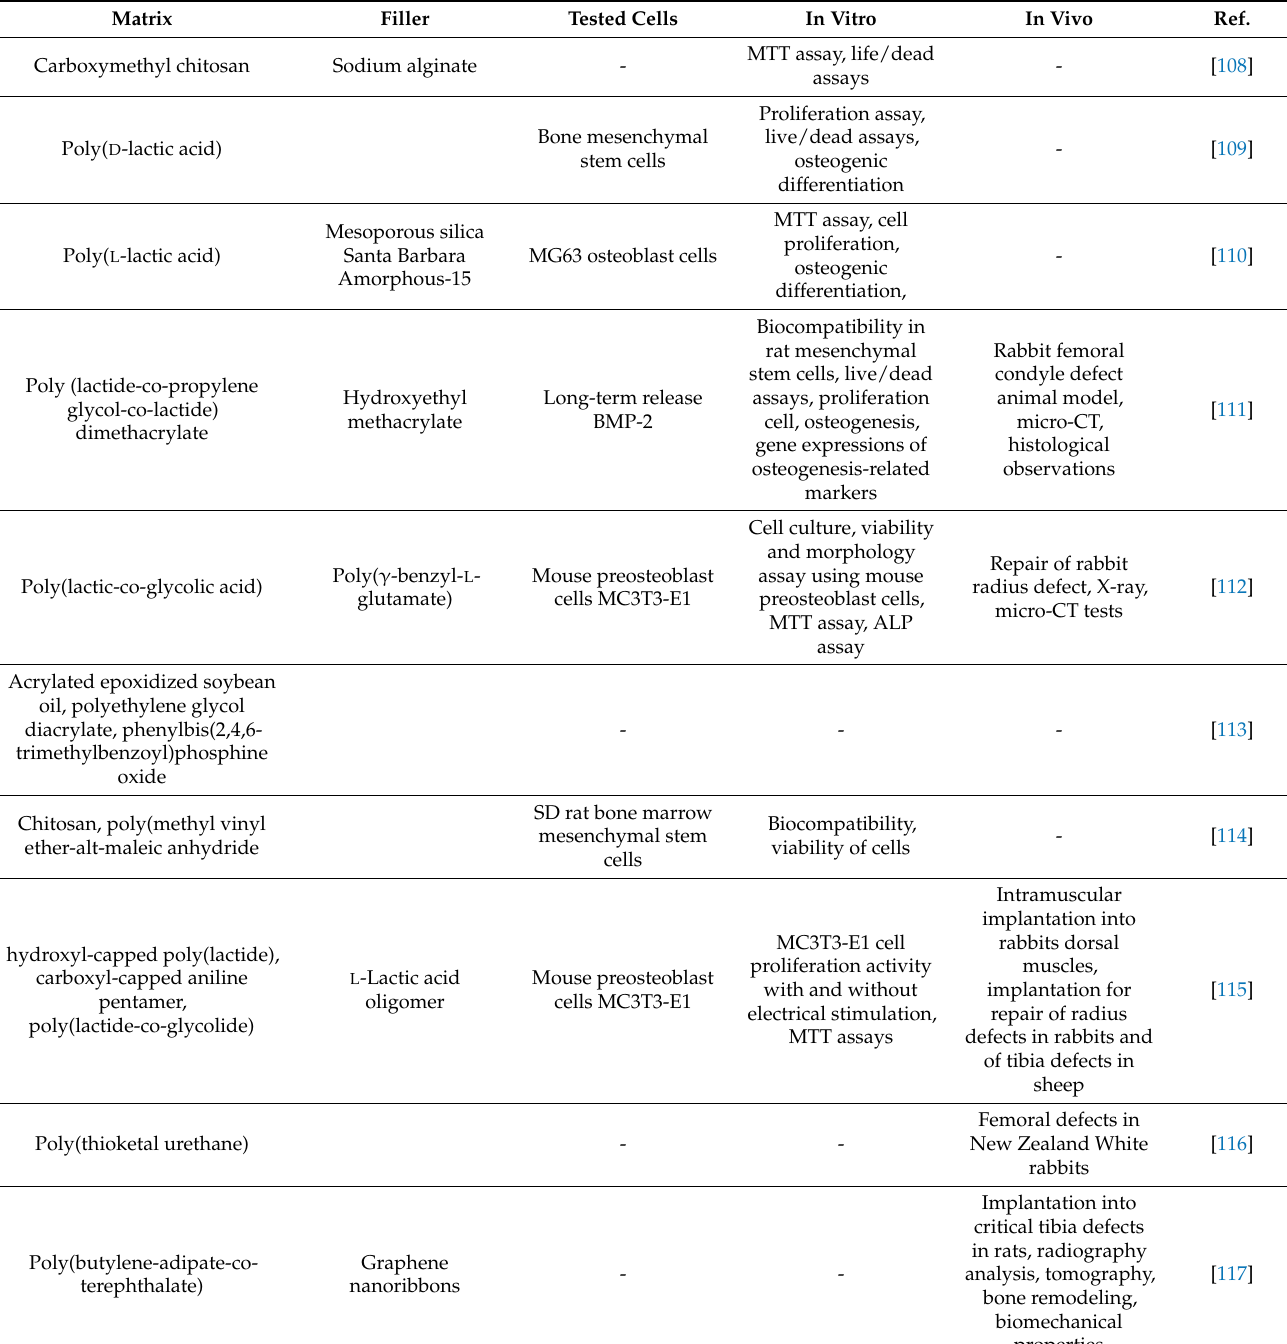
Table 2. Summary of composite materials containing nano-hydroxyapatite as basic filler (only any other fillers are listed).